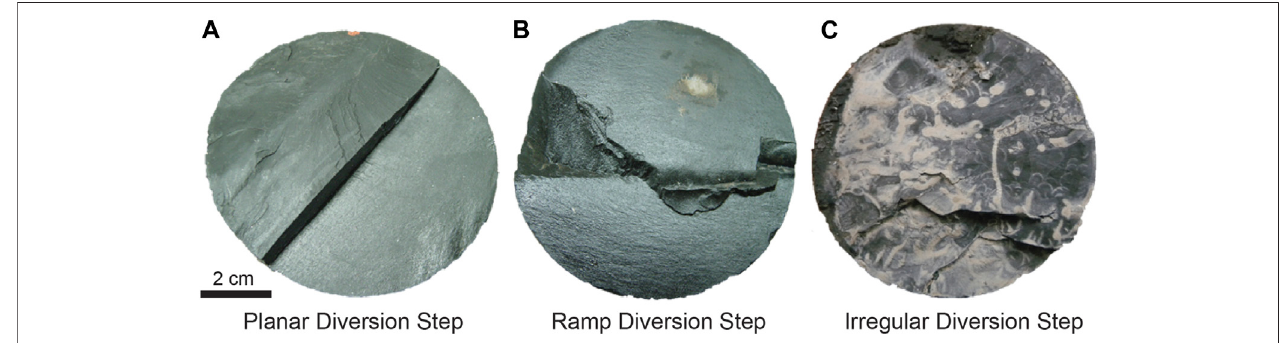
FIGURE 3 | Three examples of different diversion step morphologies observed in core. (A) displays a sharp-angled step, (B) displays smooth, curved ramps, and (C) displays a highly irregular series of step and ramp features.